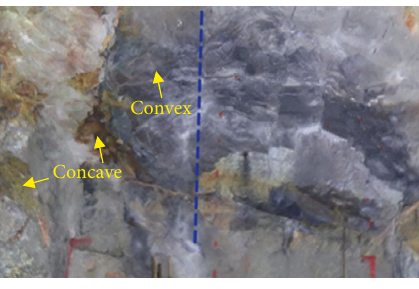
Figure 6: Blasting